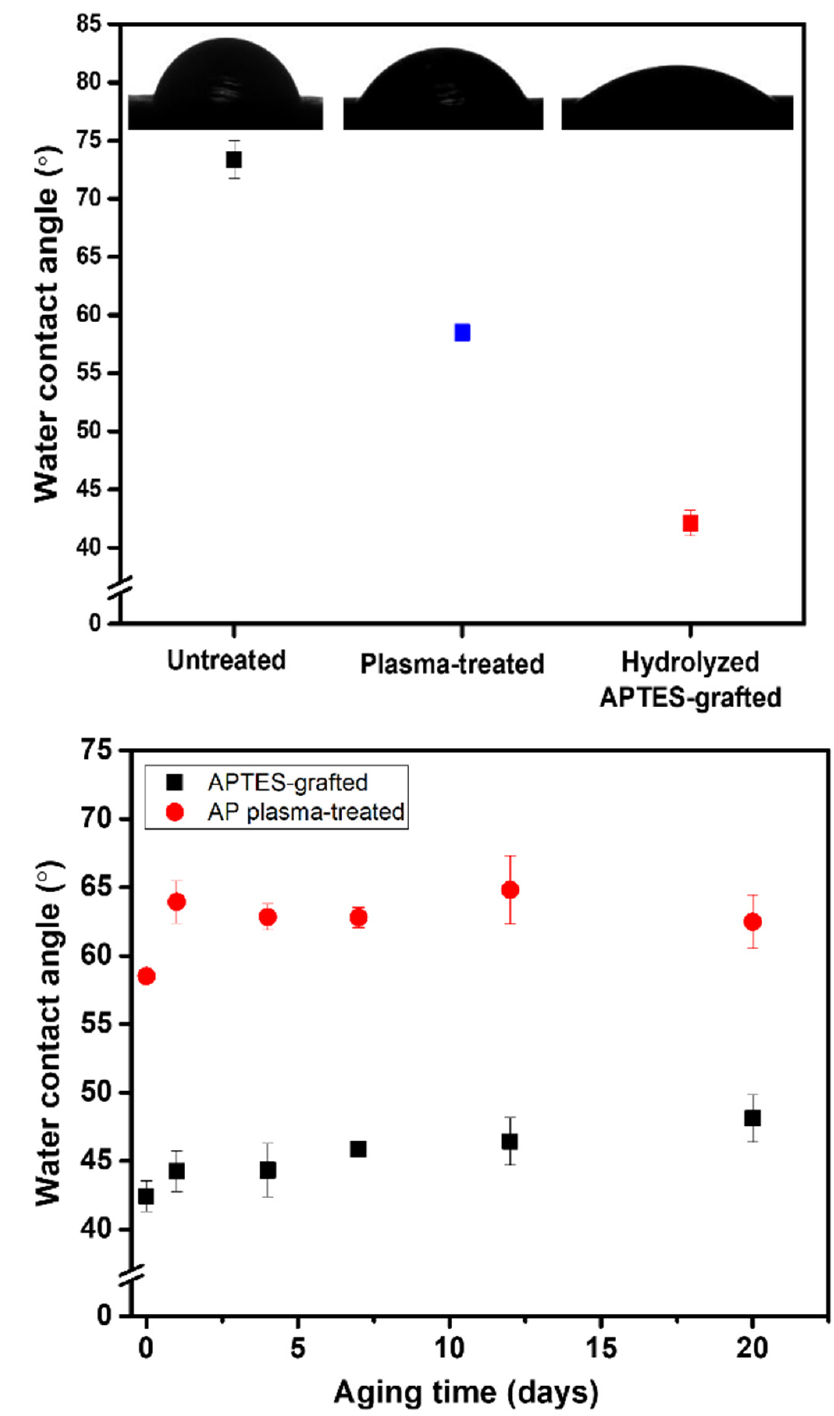
Figure 3. ( a ) Plot of water contact angle versus and the CCD images of contact angle correspond with untreated, plasma-treated, and hydrolyzed APTES-grafted; ( b ) Plot of water contact angle versus aging time.